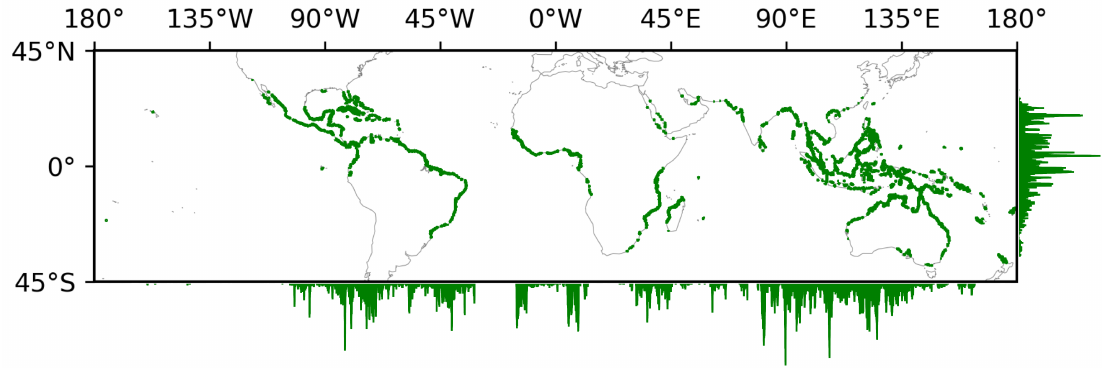
Figure 4. GMW mangrove baseline for 2010 and distribution of mangroves in longitude and latitude (WGS-84; epsg:4326).